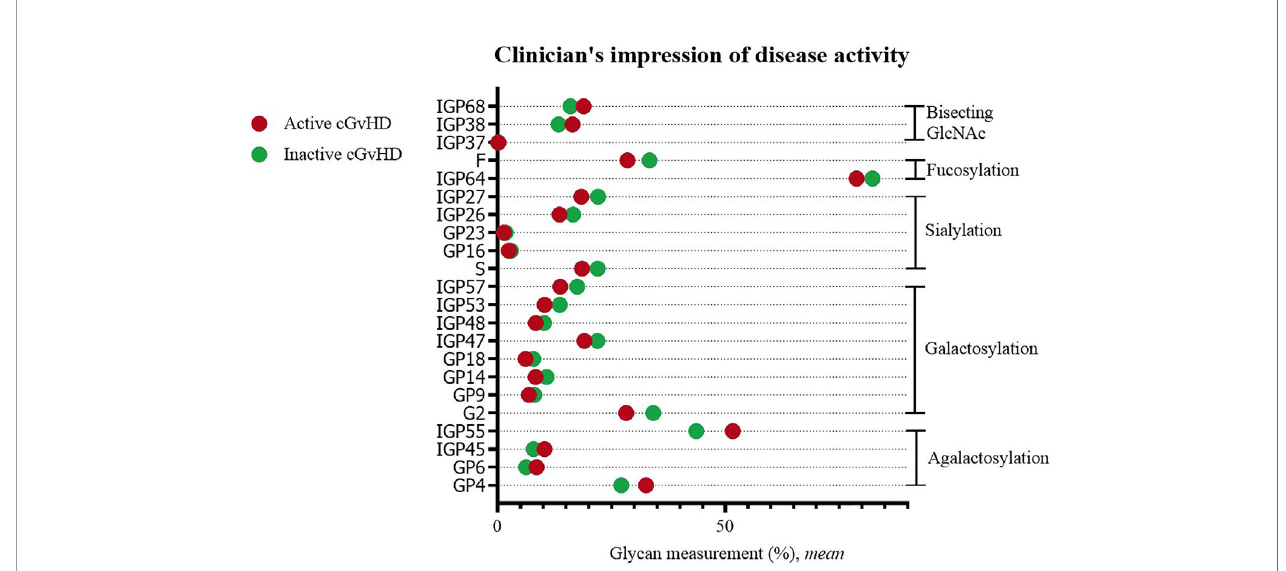
FIGURE 3 | Signi fi cant differences in glycan measurements in patients with active and inactive cGvHD (by clinician ’ s